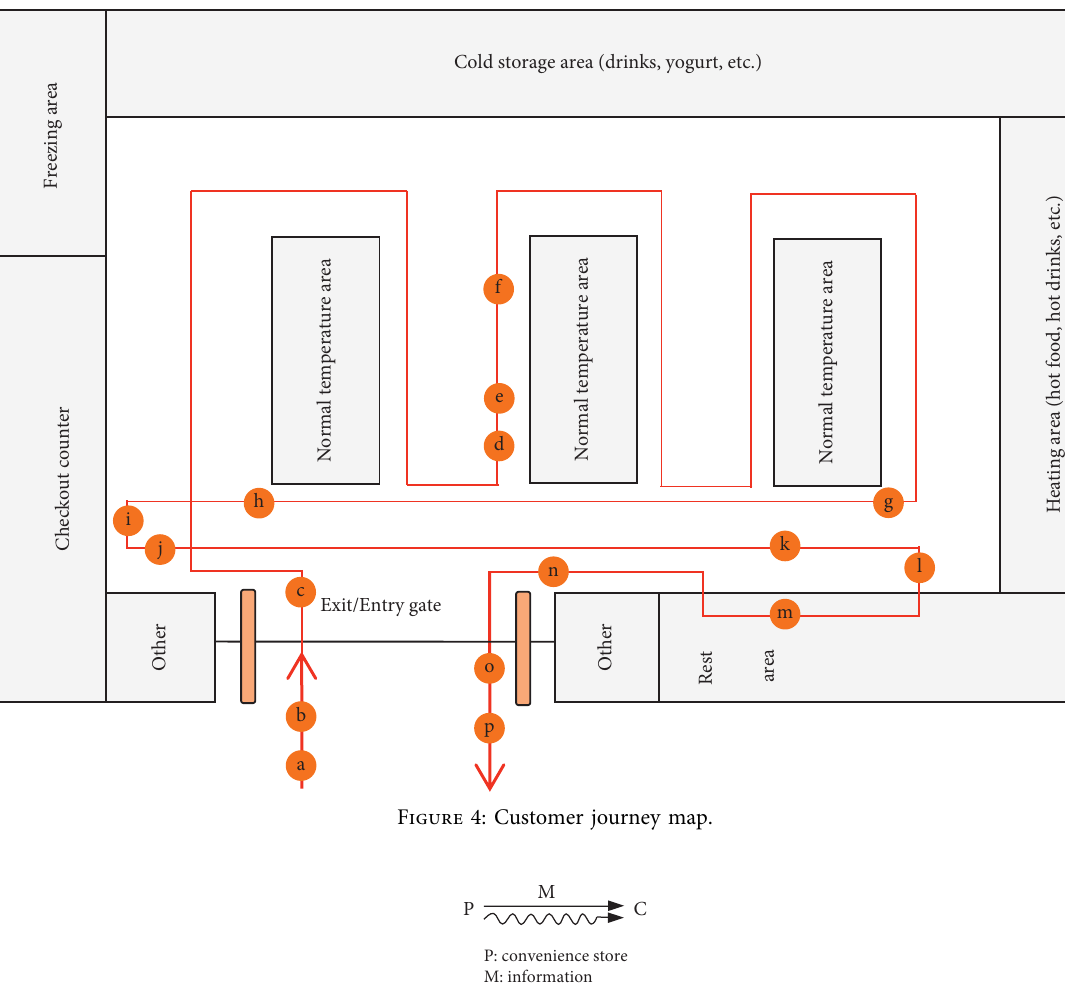
Figure 4: Customer journey map.